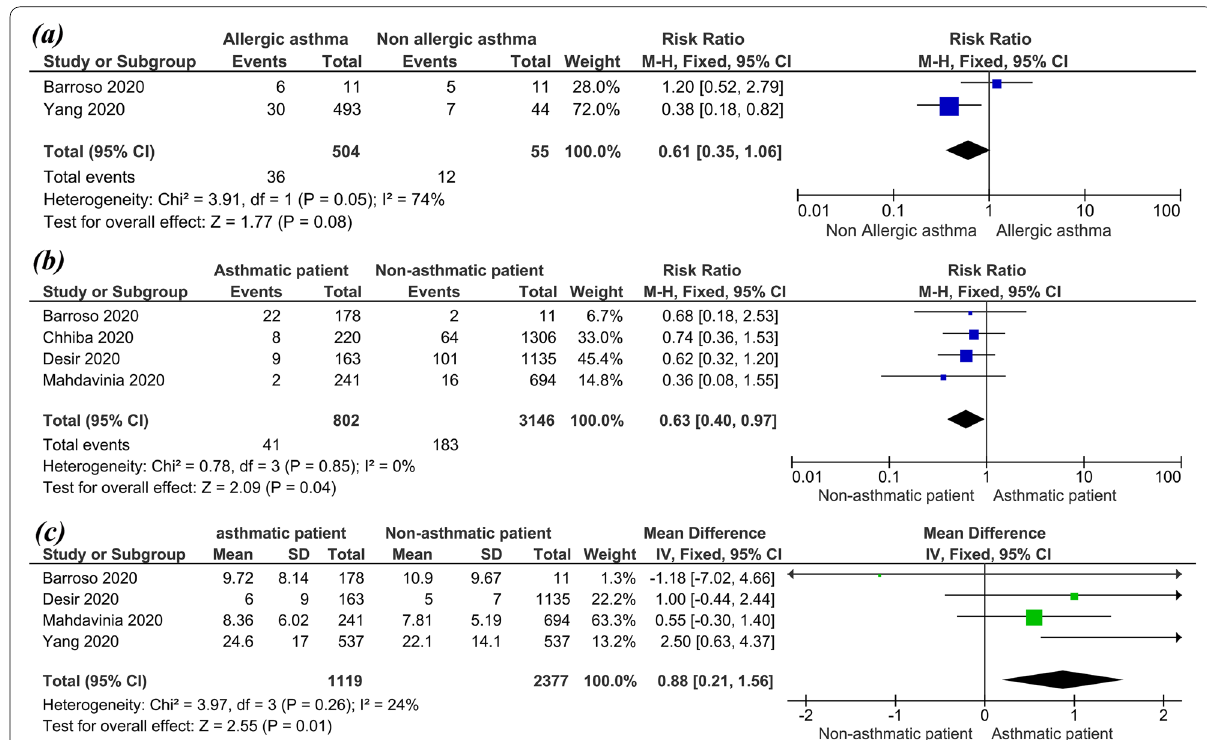
Fig. 7 a The prevalence of COVID‑19 in allergic and non‑allergic asthmatics patients. b The mortality rate in asthmatics COVID‑19 patients compared with non‑asthmatics COVID‑19 patients. c The hospitalization time in asthmatics COVID‑19 patients compared with non‑asthmatics COVID‑19